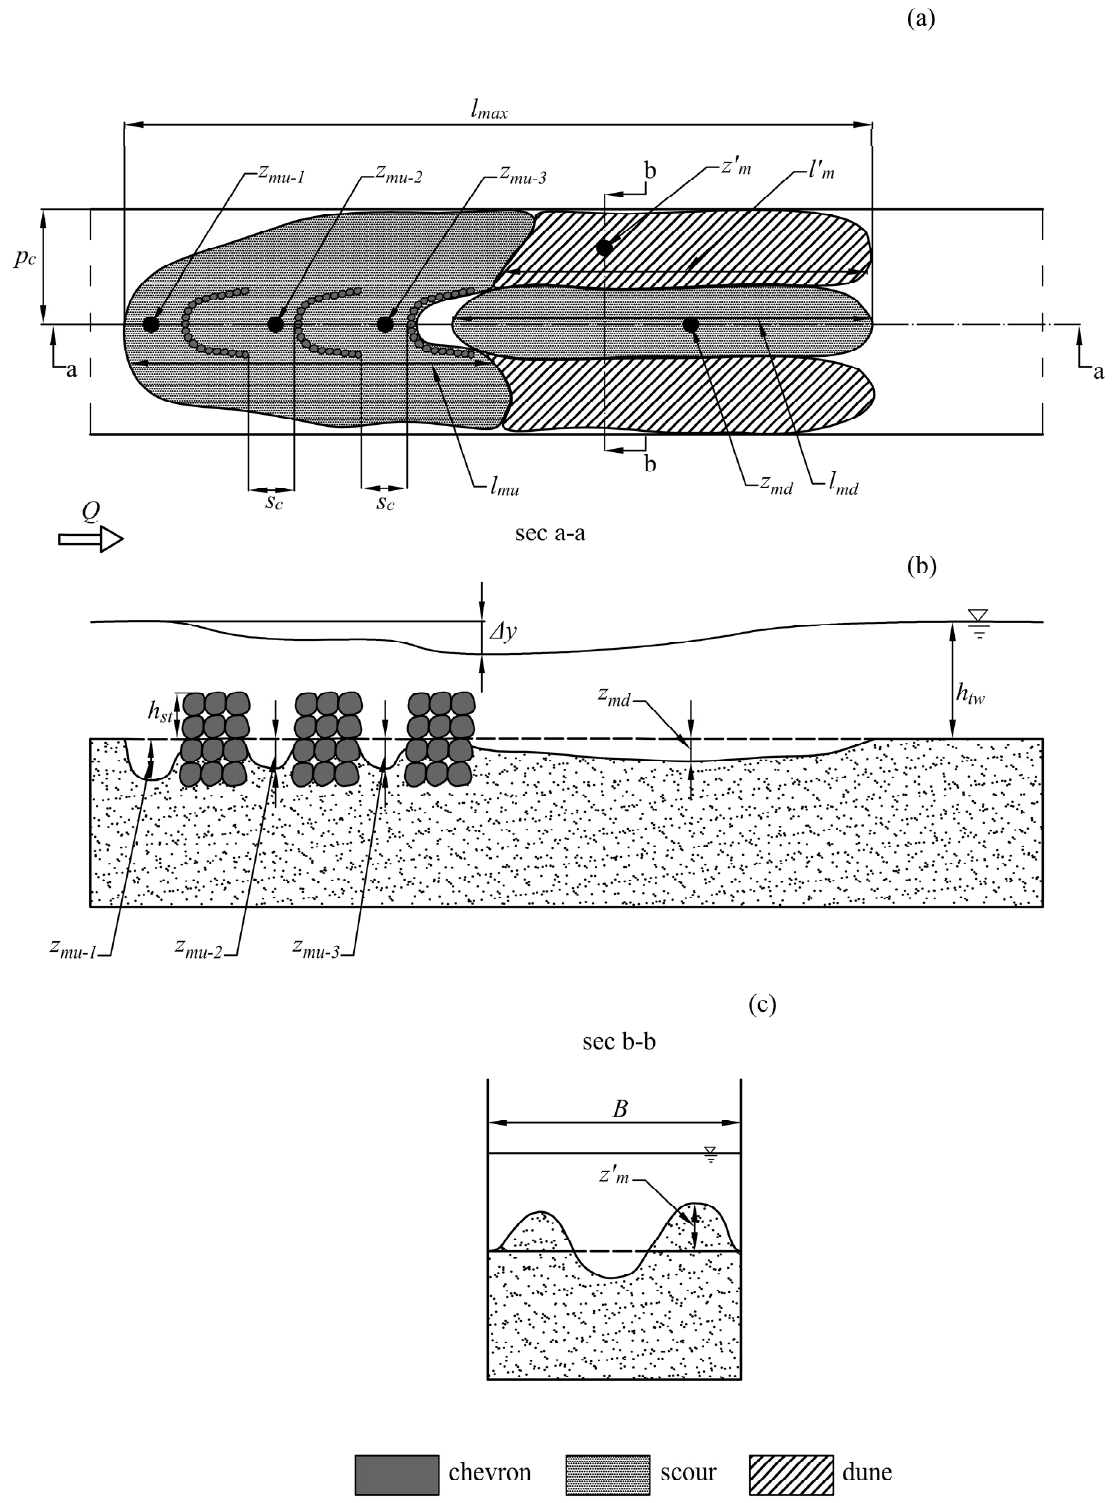
Figure 2. ( a ) Plan and ( b ) cross-sectional views of the chevron series arrangement along with the main parameters; ( c ) cross-sectional view of the bed morphology at section b-b .